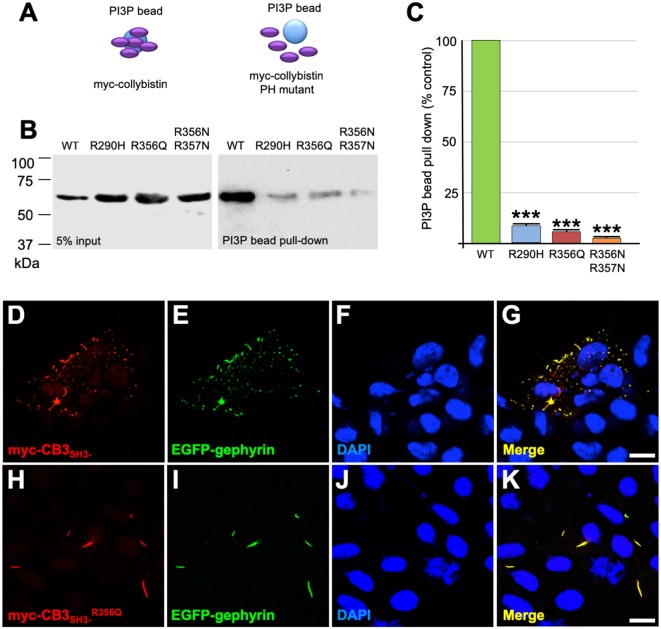
R356Q reduces collybistin PI3P binding and gephyrin cluster formation in cellular assays. (A,B) Human embryonic kidney 293 (HEK293) cells were transfected with plasmids encoding myc-CB3SH3- (wild-type, WT), myc-CB3SH3-R356Q (R356Q), myc-CB3SH3-R290H (R290H) or myc-CB3SH3-R356Q (R356N/R357N) and cell lysates were incubated with PI3P-conjugated agarose beads. After washing, bound material was subjected to SDS-PAGE and analyzed by immunoblotting with an anti-myc antibody (Sigma). No significant differences were observed in total level of myc-CB3SH3-R356Q, myc-CB3SH3-R290H or myc-CB3SH3-R356N/R357N expression in comparison with myc-CB3SH3- (left panel, 5% input protein). However, myc-CB3SH3-R356Q myc-CB3SH3-R290H and myc-CB3SH3-R356N/R357N binding to PI3P was significantly reduced (right panel, PI3P bead pull-down). (C) Quantification of PI3P pull-down assays normalized to wild-type myc-CB3SH3-: myc-CB3SH3-R290H: 8.73 ± 0.79, 1.37; myc-CB3SH3-R356Q: 7.62 ± 0.97, 1.68; myc-hCB3SH3-R356N/R357N: 3.41 ± 0.85, 1.47; pull-down fraction ± SEM, SD; n = 3, *** p < 0.0001, unpaired student’s t-test. (D–K) HEK293 cells were co-transfected with EGFP-gephyrin and either wild-type myc-CB3SH3- or mutant myc-CB3SH3-R356Q, immunostained using anti-myc and AlexaFluor 546 antibodies and co-stained with a nuclear marker (DAPI). Note that while wild-type myc-CB3SH3- (red) co-localizes with gephyrin (green) in submembrane microaggregates (D–G), mutant myc-CB3SH3-R356Q (red) co-localizes with EGFP-gephyrin (green) in elongated cytoplasmic aggregates (H–K), consistent with a lack of CB-mediated gephyrin clustering activity for the p.R356Q mutant. Scale bar = 10 μm.